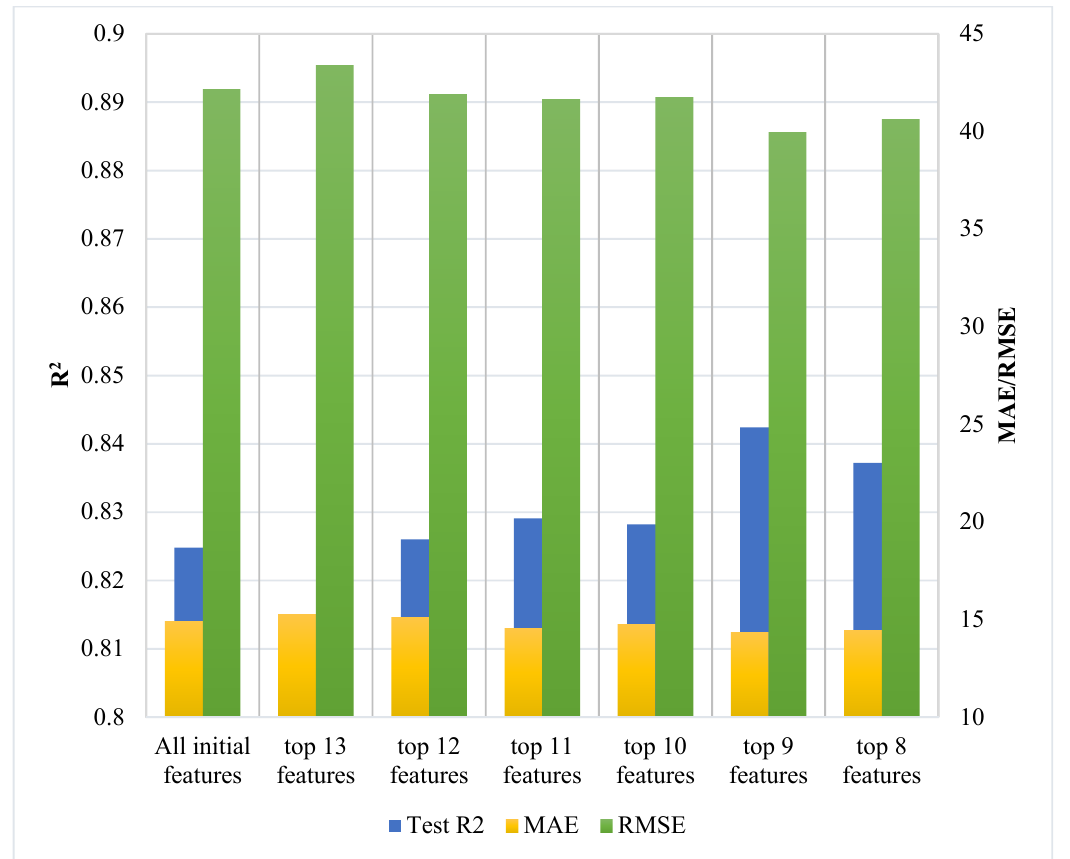
Figure 13. Evaluation of the performances of top features using the Gradient Boosting Regressor.